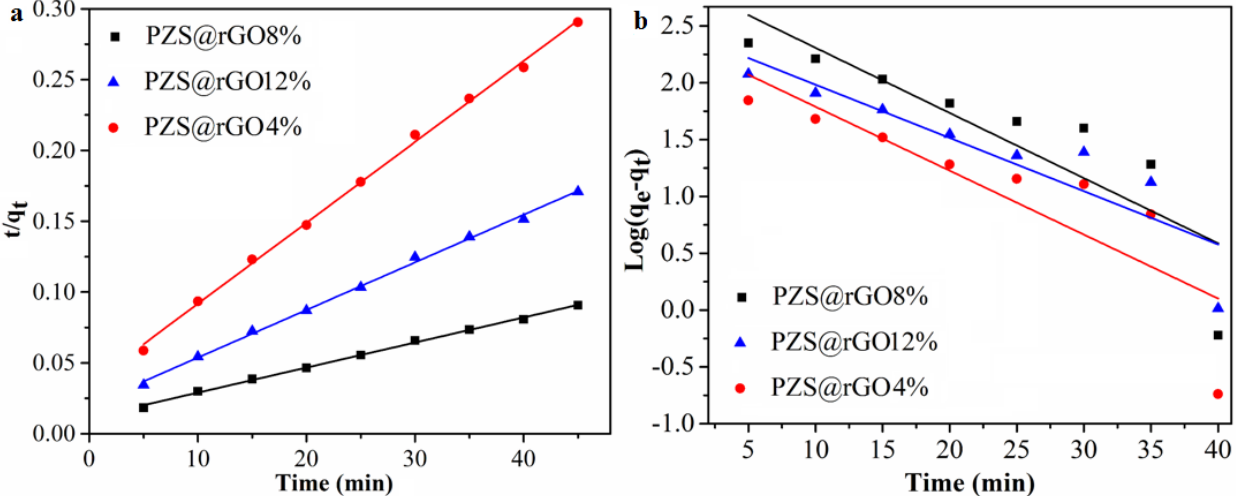
Figure 7. Linear fitting of Pseudo-second-order ( a ) and pseudo-first-order kinetics ( b ) for TC adsorption (C 0 = 100 ppm). Table 1. Adsorption parameters for pseudo-first-order and pseudo-second-order models.